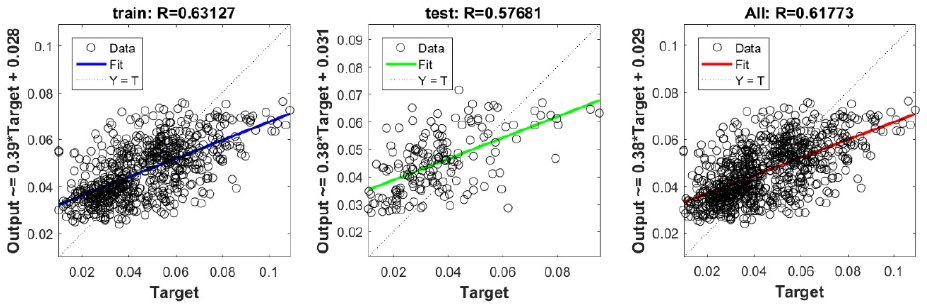
Figure A1. Scatter plots between target and output value by the FS-SVR model.